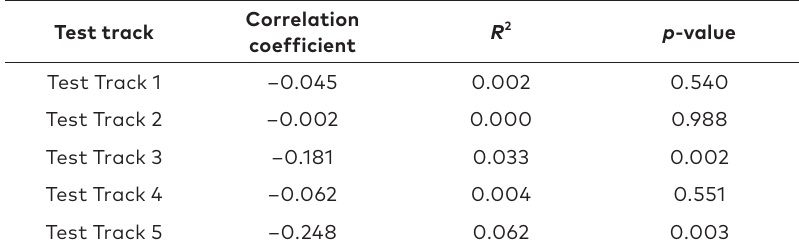
Plot of Fitted Model Water droplets T5 = 897.114 – 488.198 × MPD T5